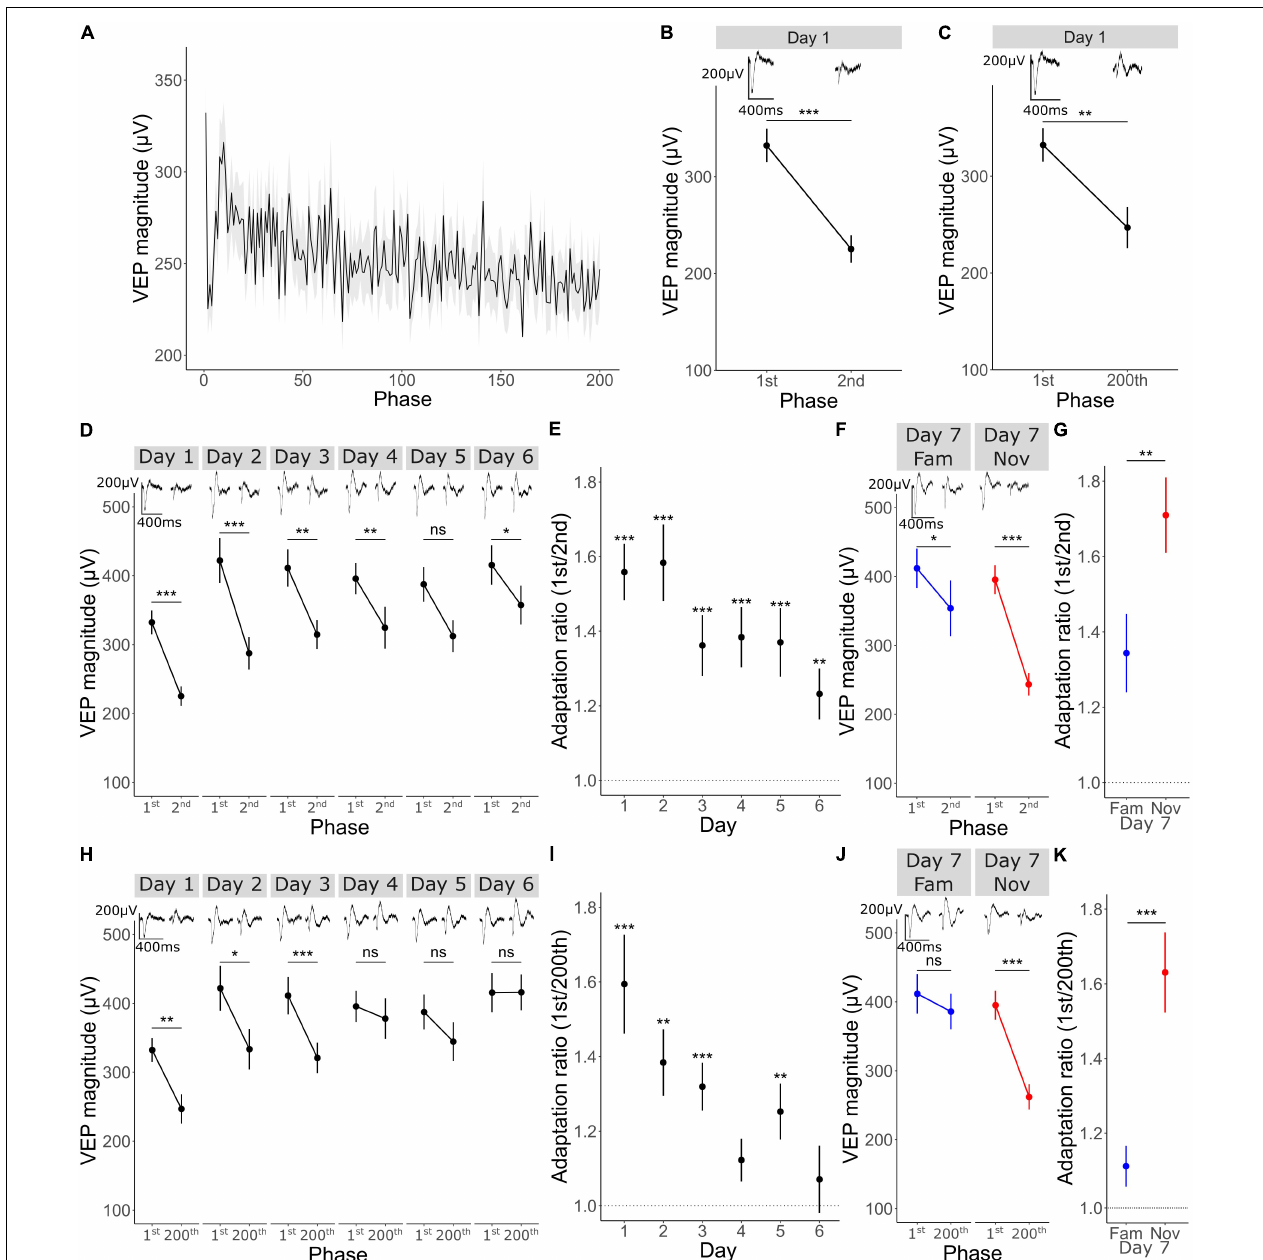
FIGURE 2 | Short-term adaptation occurs within a stimulus block and is modulated by familiarity. (A) Mean ± SEM VEP magnitude for phase reversal 1–200 ( n = 33). (B) VEP magnitude in response to the first phase reversal and the 2nd, Wilcoxon signed rank 1st vs. 2nd: p < 0.001 ( n = 33). (C) VEP magnitude in response to the first phase reversal and the 200th, Wilcoxon signed rank 1st vs. 200th: p = 0.001 ( n = 33). (D) VEP potential magnitude in response to the 1st vs. 2nd phase reversal over 6 days ( n = 33). Wilcoxon signed rank 1st vs. 2nd day 1: p < 0.001, day 2: p < 0.001, day 3: p = 0.002, day 4: p = 0.008, day 5: p = 0.05, day 6: p = 0.04. FDR correction for multiple comparisons. (E) Adaptation ratio (1st/2nd) over 6 days. Wilcoxon signed-rank test on AR ( µ = 1) day 1: p < 0.001, day 2: p < 0.001, day 3: p < 0.001, day 4: p < 0.001, day 5: p < 0.001, day 6: p = 0.002. FDR correction for multiple comparisons. (F) VEP potential magnitude in response to the 1st vs. 2nd phase reversal on day 7 ( n = 33). Wilcoxon signed rank 1st vs. 2nd day 7 fam: p = 0.02, day 7 nov: p < 0.001. FDR correction for multiple comparisons. (G) Adaptation ratio (1st/2nd) on day 7. Wilcoxon signed-rank test fam vs. nov: p = 0.009. (H) VEP potential magnitude in response to the 1st vs. 200th phase reversal over 6 days ( n = 33). Wilcoxon signed rank 1st vs. 200th day 1: p = 0.008, day 2: p = 0.04, day 3: p < 0.001, day 4: p = 1, day 5: p = 0.4, day 6: p = 1. (I) Adaptation ratio (1st/200th) over 6 days. Wilcoxon signed-rank test on AR ( µ = 1) day 1: p < 0.001, day 2: p = 0.001, day 3: p < 0.001, day 4: p = 0.1, day 5: p = 0.006, day 6: p = 1. FDR correction for multiple comparisons. (J) VEP potential magnitude in response to the 1st vs. 2nd phase reversal on day 7 ( n = 33). Wilcoxon signed rank 1st vs. 200th day 7 fam: p = 1, day 7 nov: p < 0.001. (K) Adaptation ratio (1st/200th) on day 7. Wilcoxon signed-rank test fam